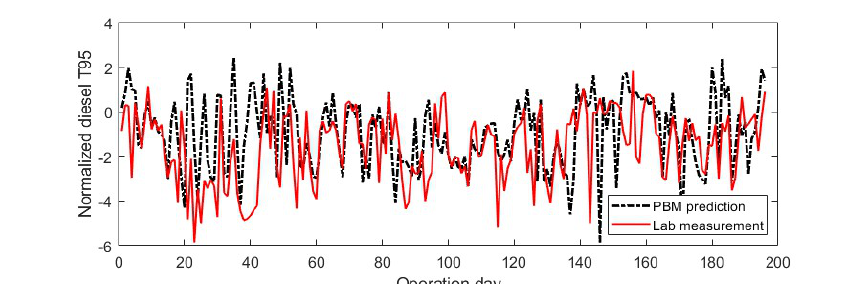
Figure 6. Physics-based model predictions against the lab measurements for independent control